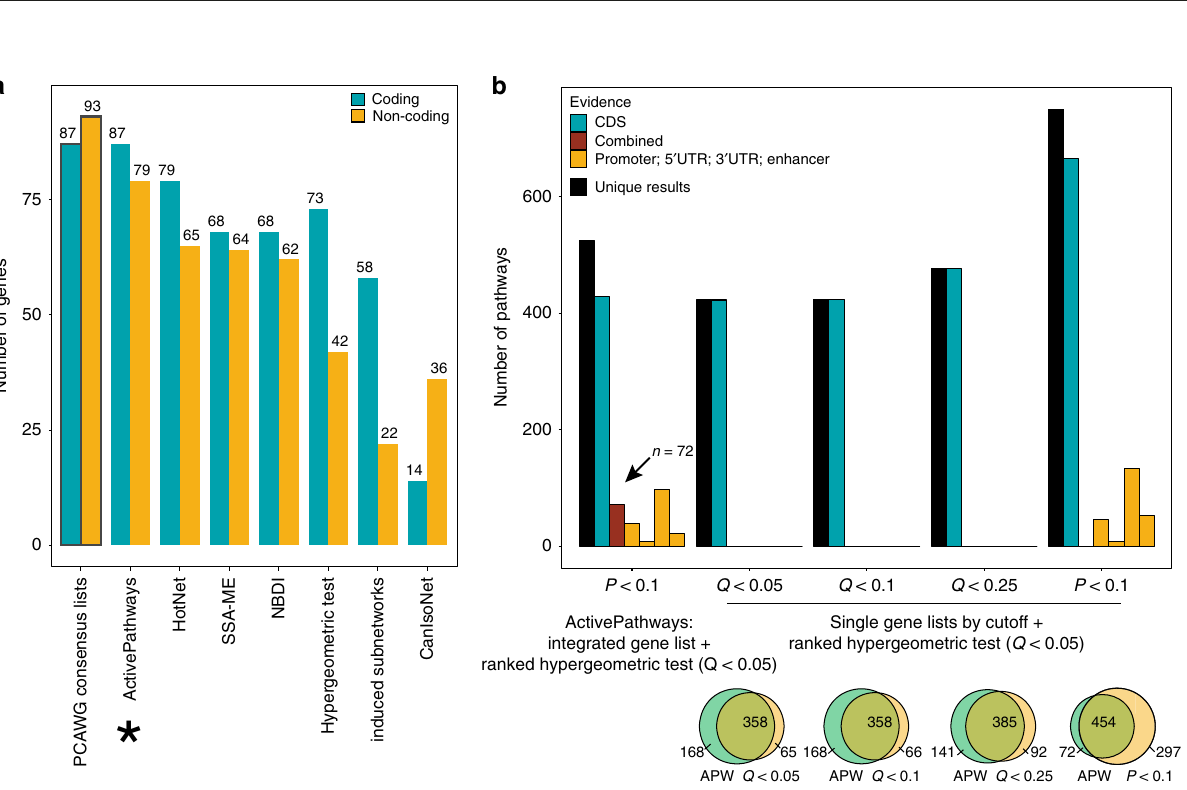
Fig. 4 Integrative pathway enrichment analysis of Hippo target genes across human tissues. a Enrichment map of GO processes and Reactome pathways enriched in the target genes of transcriptional regulators YAP and TAZ of the Hippo pathway. Co-expressed target genes of YAP and TAZ across normal human tissues of the GTEx dataset (pathways are shown in green and yellow, respectively) and DNA-binding target genes of YAP from ChIP-seq experiments (shown in blue) were analyzed. Pathways only found through the integration of ChIP-seq and RNA-seq data are shown in red. b Euler diagram shows 106 Hippo-related genes that were signi fi cantly enriched in the detected pathways and supported by a combination of signals in RNA-seq and ChIP- seq datasets. Core Hippo genes detected in the analysis are listed. c Regulatory network of 17 TFs and 1,426 target genes detected in the ActivePathways analysis of gene sets representing transcription factor target genes. Transcription factors with enriched target genes in the YAP/TAZ regulome are shown in multi-colored circles. Target genes are colored by increasing statistical signi fi cance (turquoise to red). d Integrative analysis of pathways and GO processes is complementary to the analysis of transcription factor targets. Euler diagram shows total number of pathway-associated identi fi ed in the analysis of GO and Reactome terms (left) and TF target genes from ENCODE (right). Numbers of Hippo-related genes are shown in brackets.